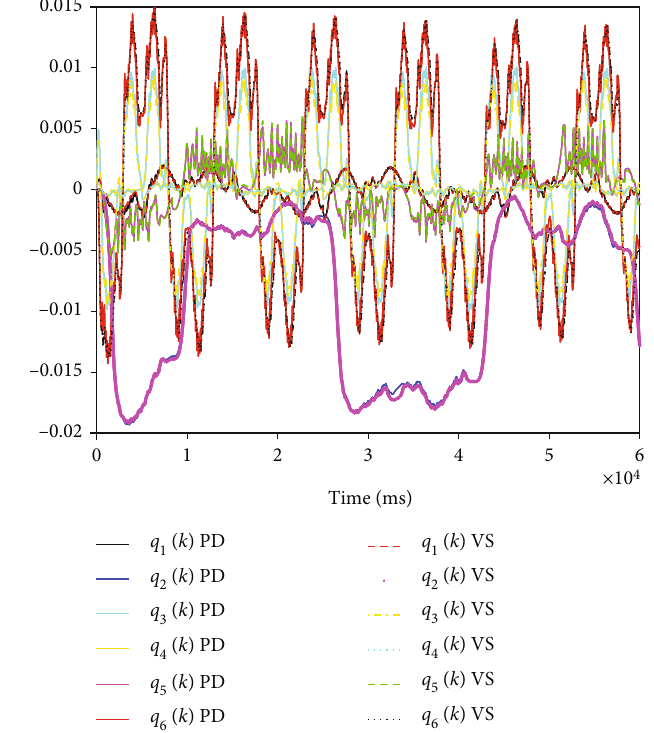
Figure 5: Tracking error comparison between variable structure control and PD